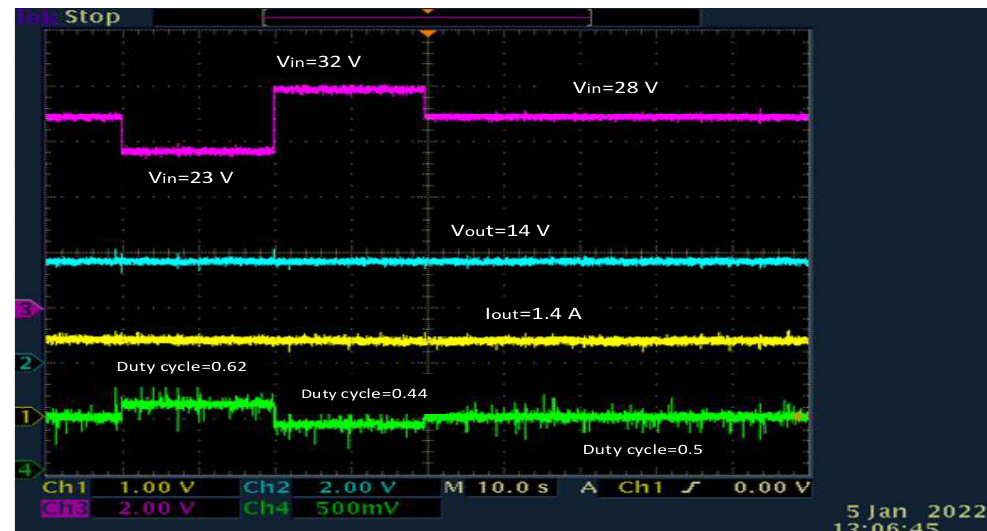
Figure 15. HIL experimental results of system with input voltage variation.